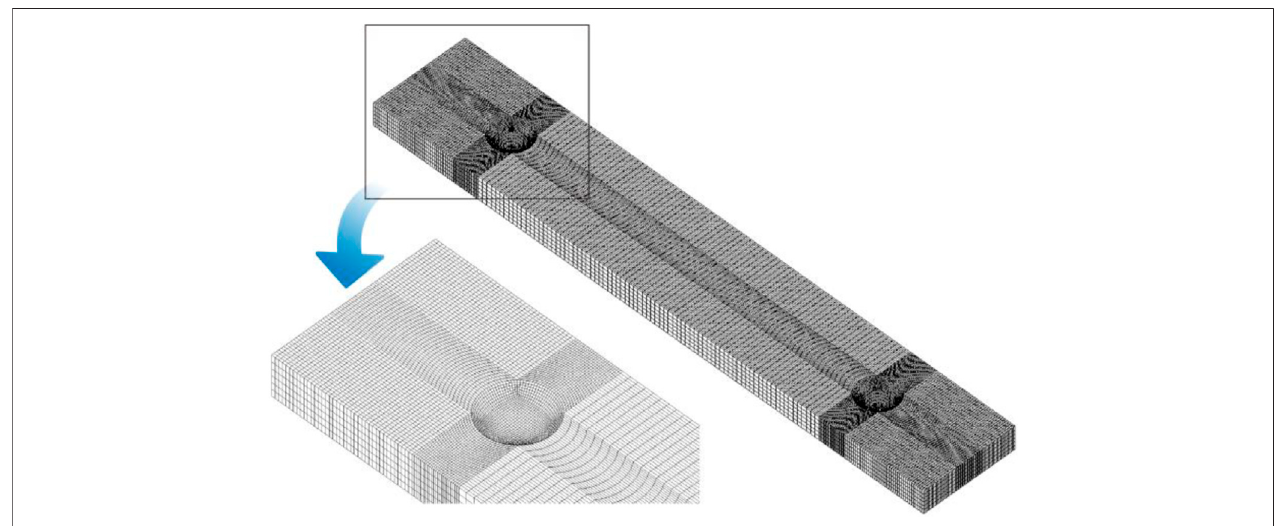
FIGURE 3 | Mesh of channel with round blisters.